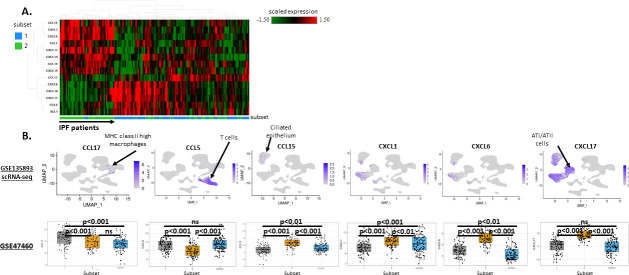
Evaluation of differential chemokine networks in IPF subsets.A. Hierarchical clustering of GSE47460 (Kaminski-LGRC bulk expression cohort) [14–17] IPF patients based on chemokines differentially expressed between IPF subsets. Absolute log FC >0.58 and adjusted p value<0.05 was used to define differentially expressed chemokines. x axis represents individual patients, y axis represents genes. Subsets are indicated in x axis color bar and legend of heatmap and correspond to classes shown in Fig 1A. B. Expression of chemokines detectable in GSE135893 (Kropski-Vanderbilt Univ single cell cohort) [24] scRNAseq data and in GSE47460 (Kaminski-LGRC bulk expression cohort) [14–17] IPF subsets. scRNAseq UMAP plots (top row) were generated using the ‘FeaturePlot’ function in R package Seurat. Each UMAP plot depicts the expression of the chemokine indicated. Color bars indicate scaled expression in each cell on the plot. Cell clusters correspond to clusters reported in S5 Fig. Bar plots (bottom row) depict the expression of the same chemokines in GSE47460 (Kaminski-LGRC bulk expression cohort) [14–17] IPF subsets. Adjusted p values are reported on plots.